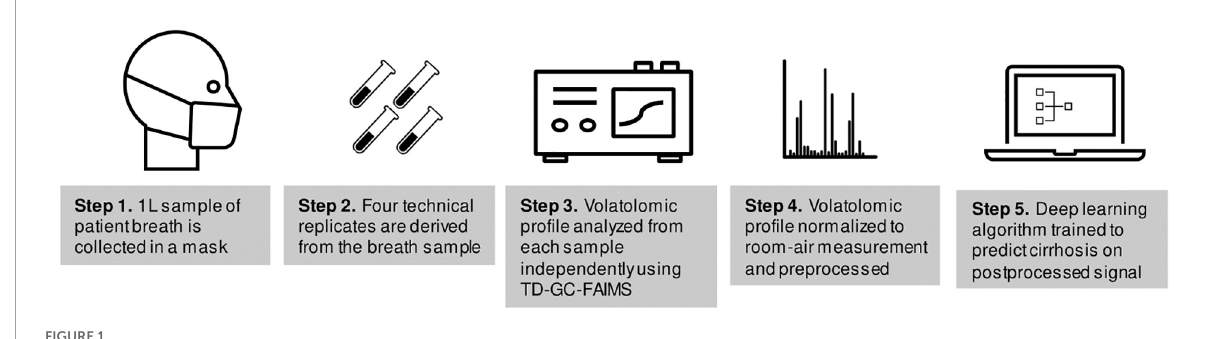
FIGURE1 Flow-chart of sample collection and